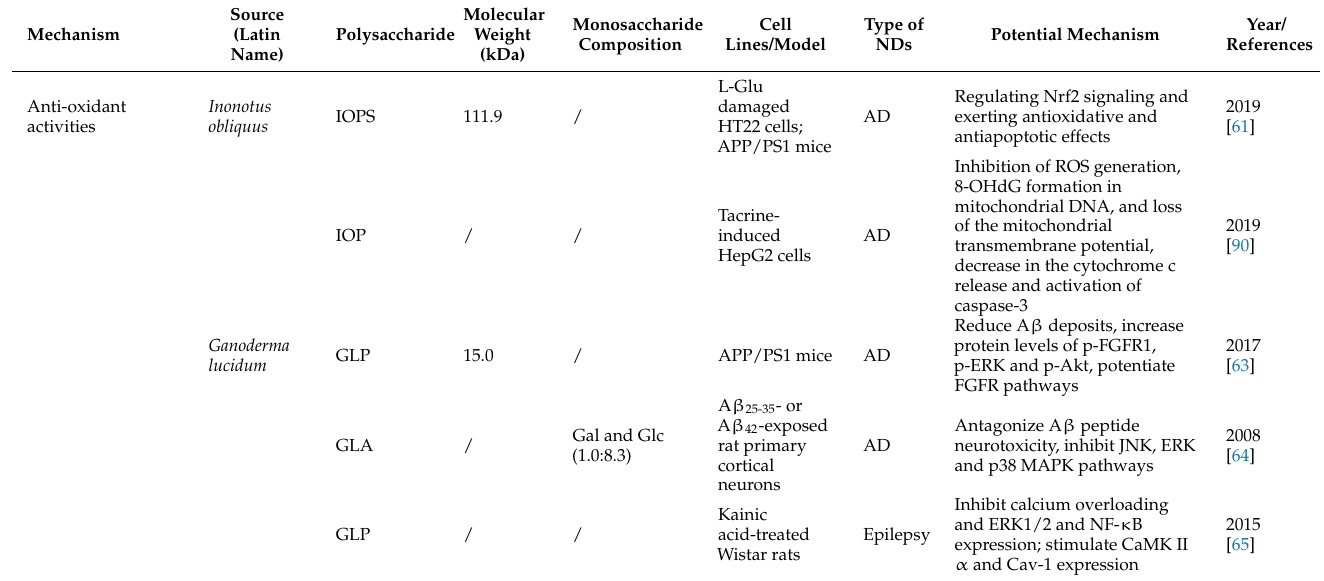
Table 1. Effects of mushroom polysaccharides on